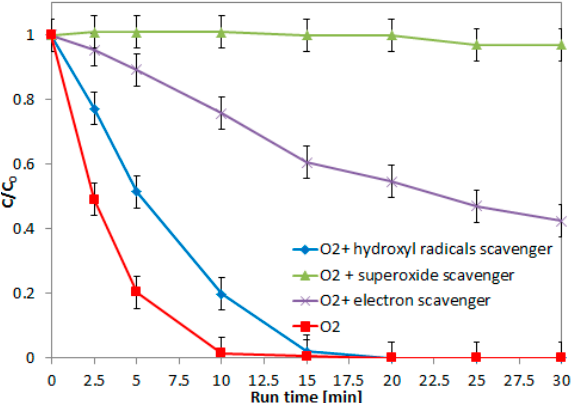
Figure 8. Influence of reactive oxygen species (ROS) on AO7 degradation in a DBD reactor in the presence SF2 catalyst. AO7 initial concentration: 20 mg/L. Applied voltage: 12 kV. O 2 flow rate: 0.18 presence SF2 catalyst. AO7 initial concentration: 20 mg / L. Applied voltage: 12 kV. O 2 flow rate: NL/min. 0.18 NL /